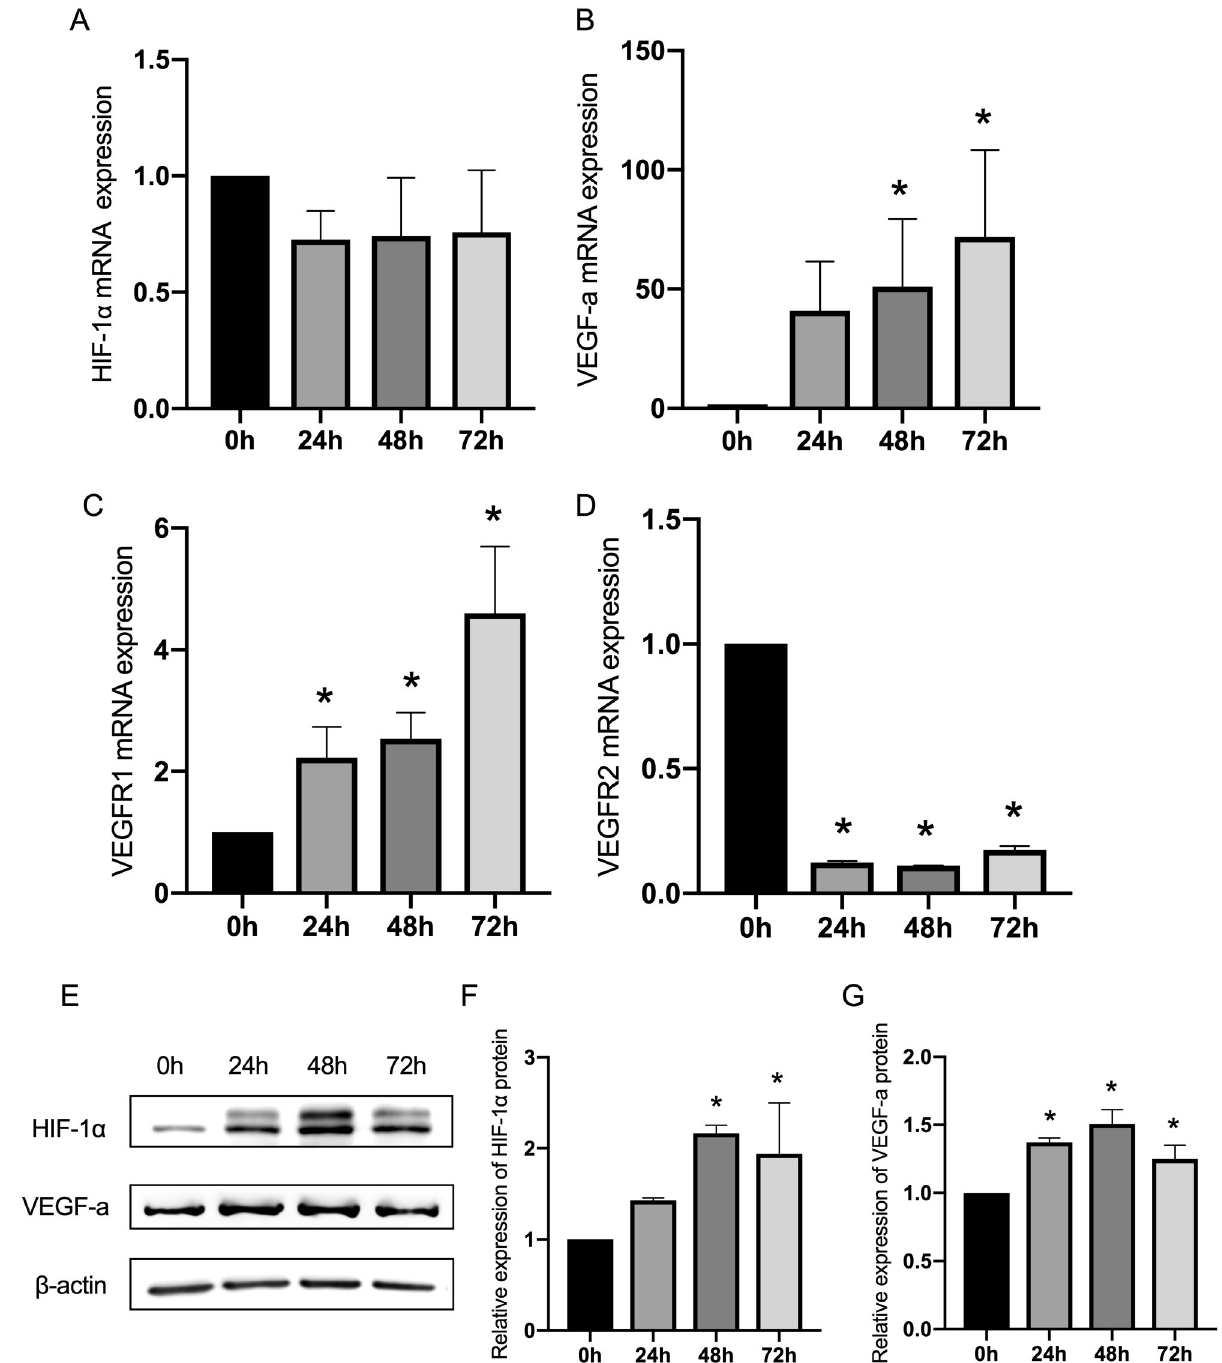
Fig 3. The hypoxia-induced changes of HIF-1 α , VEGF-a, VEGFR1 and VEGFR2 at the mRNA and protein level. (A, B, C and D) The ECs were exposed to hypoxia for 72 hours, and the mRNA expression of HIF-1 α , VEGF-a, VEGFR1 and VEGFR2 was analyzed. (E) The representative images from the western blot performed for the detection of HIF-1 α and VEGF-a. (F and G) Densitometric analyses of the western blot experiments. The above experiments were repeated three times independently. The statistical differences were assessed by one-way analysis of variance (ANOVA) (Kruskal–Wallis), followed by Dunn’s posthoc test. � P < 0.05 against the untreated condition. The graph bars show the mean ±